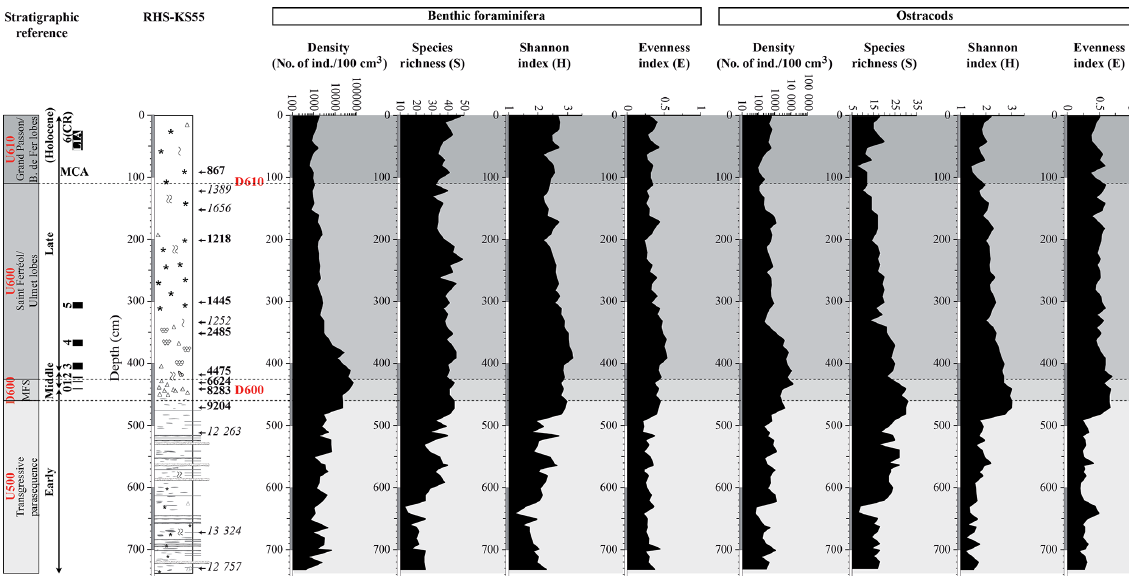
Figure 6. Ecological indices (total abundance per 100cm 3 , number of species ( S ), Shannon ( H ), and evenness ( E ) index) describing benthic foraminiferal and ostracod populations. Correlations with seismic units and discontinuities are shown on the left side of the figure. The corresponding positions of seismic units and discontinuities (U500, U600, U610, D600, and D610) are also reported on the plots (gray bands and dashed lines). Black rectangles on the left side of the figure represent the most significant periods of climate deterioration (i.e., cold relapses (CRs)) during the Holocene.